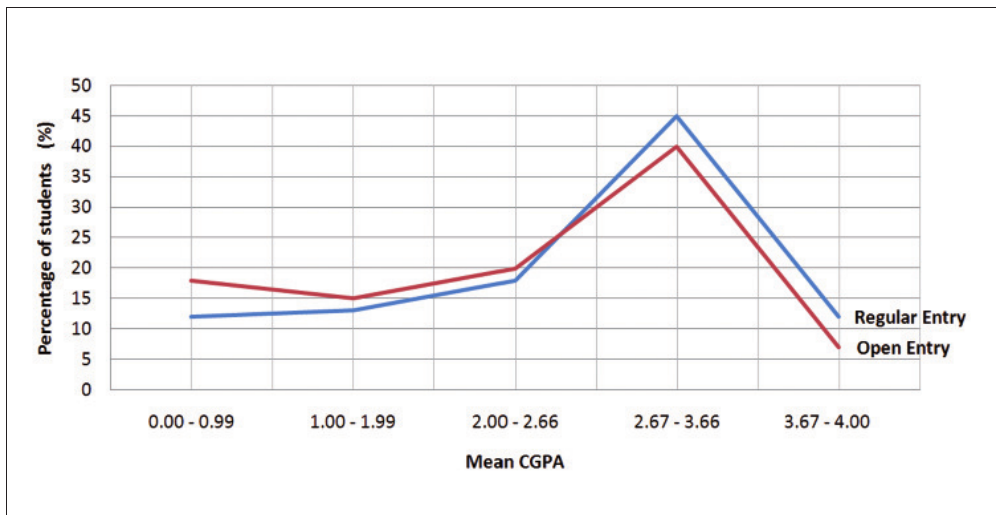
Figure 7 Mean CGPA performance of Open Entry and Regular Entry students ( p<0.05